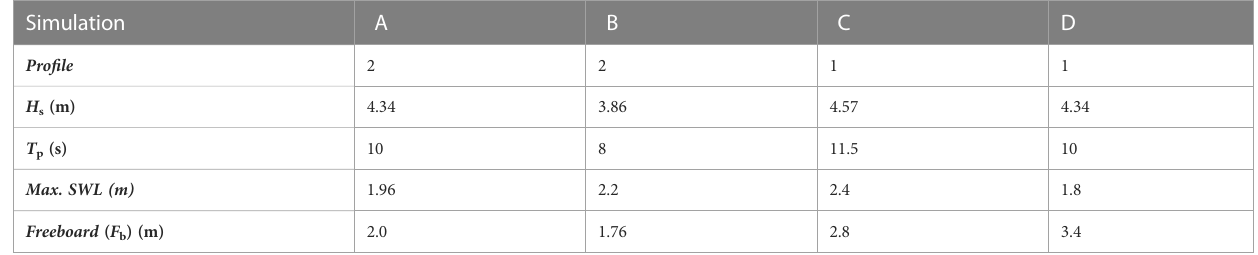
TABLE 4 Unimodal storm conditions used for a detailed investigation of spatio-temporal barrier evolution and the development of morphodynamic regimes shown in Figure 5 . Simulation